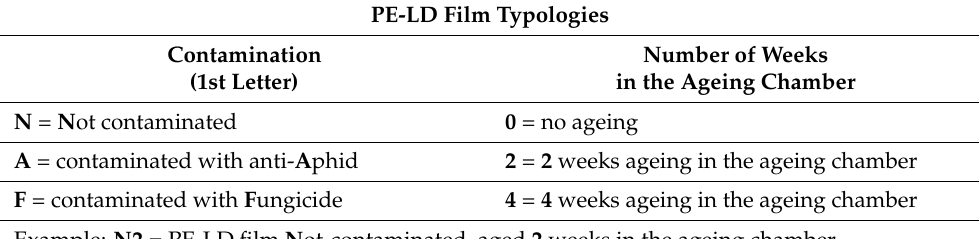
Table 1. Nomenclature of the tested PE-LD